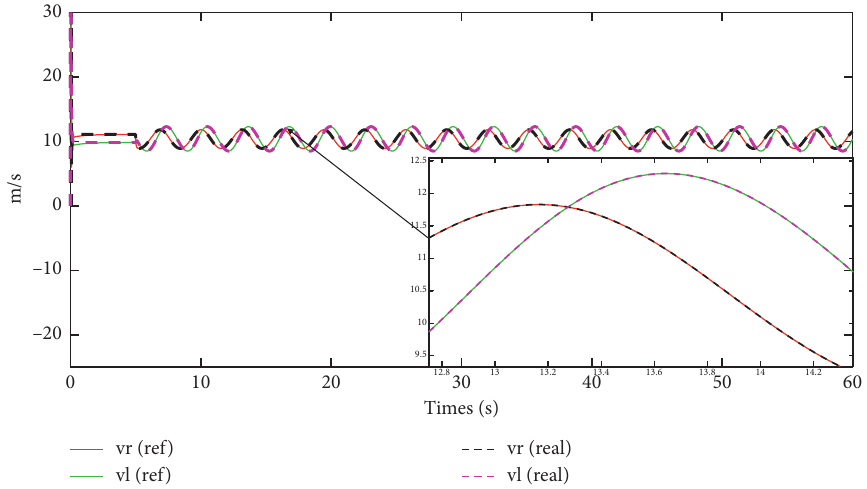
Figure 4: The real velocity of T-S fuzzy type-II controller for elliptical